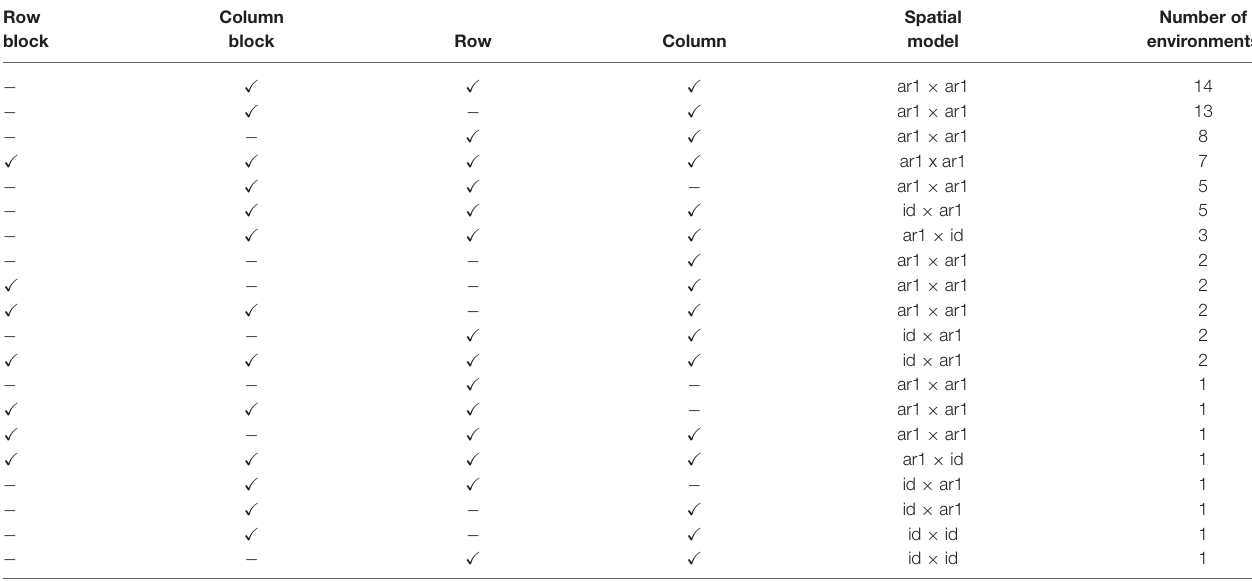
TABLE 3 | Summary of non-genetic effects and spatial models for individual environments in the FALMM. Row Column Spatial Number of block block Row Column model environments − X X X ar1 × ar1 X − X ar1 × ar1